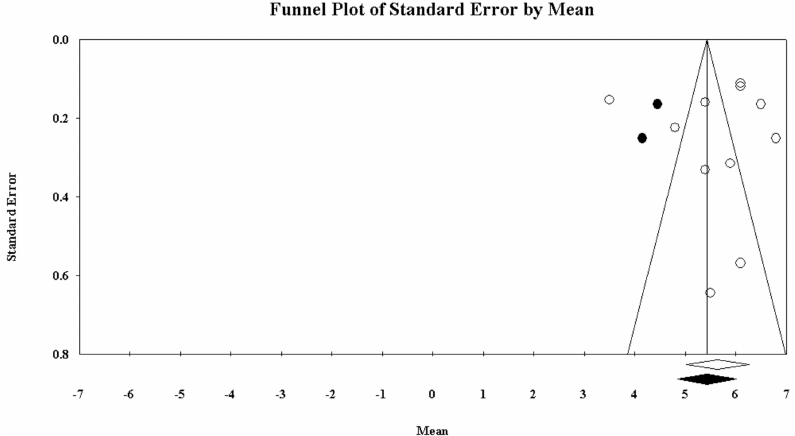
Figure 8. Funnel plot of the meta-analysis of the pooled PSQI global score in police